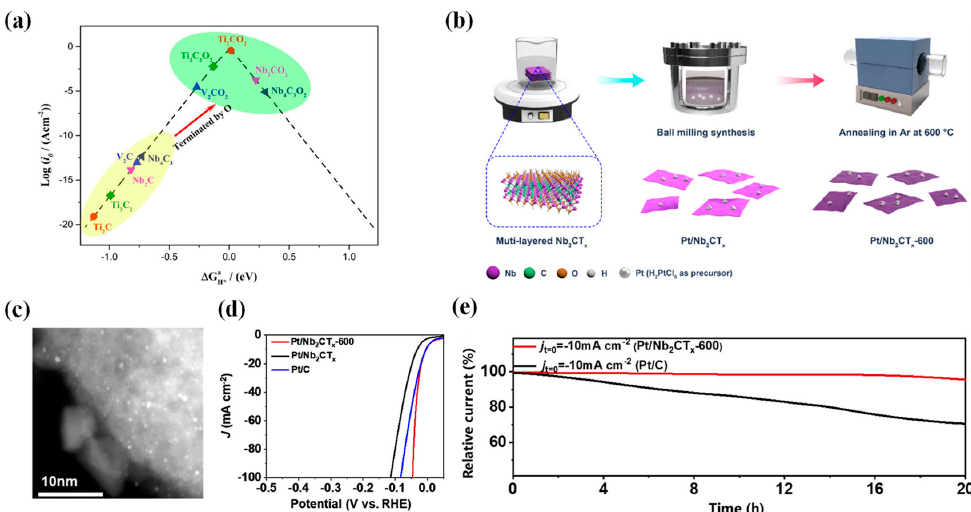
Figure 11. Applications of Nb 2 CT x in electrocatalytic hydrogen evolution reaction. ( a ) Volcano curve of exchange current (i 0 ) as a function of the average Gibbs free energy of hydrogen adsorption ( Δ G aH* ).[17] Copyright American Chemical Society, 2016. ( b ) Schematic illustration of the preparation of Pt/Nb 2 CT x -600 catalyst, ( c ) TEM image of Pt/Nb 2 CT x -600, ( d ) Electrocatalytic HER performance of Pt/Nb 2 CT x -600 in 0.5 M H 2 SO 4 , ( e ) CA curves of Pt/Nb 2 CT x -600 and Pt/C catalysts for HER performance. [116] Copyright MDPI, 2021.